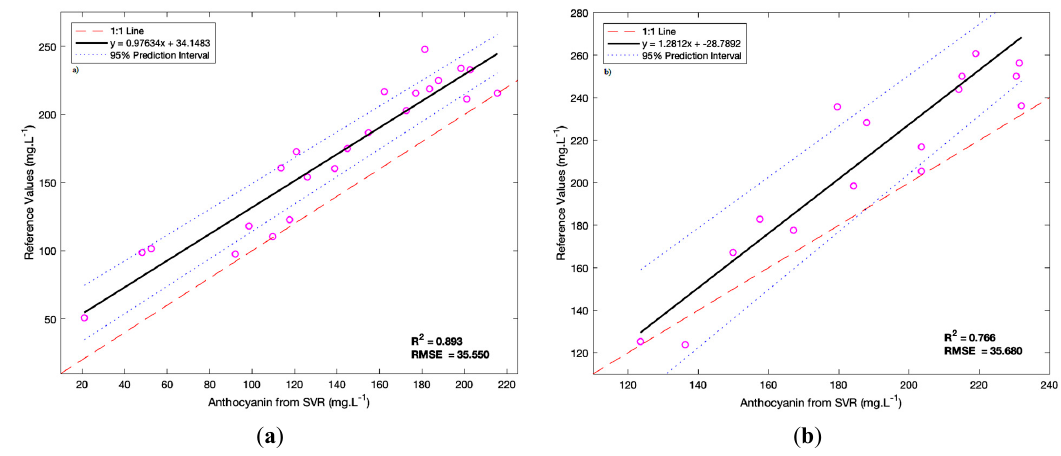
Figure 5. Results for the determination of the anthocyanin concentration in the external test sets to further study the generalization capacity; ( a ) TB 2013 samples; ( b ) TN 2013 samples.